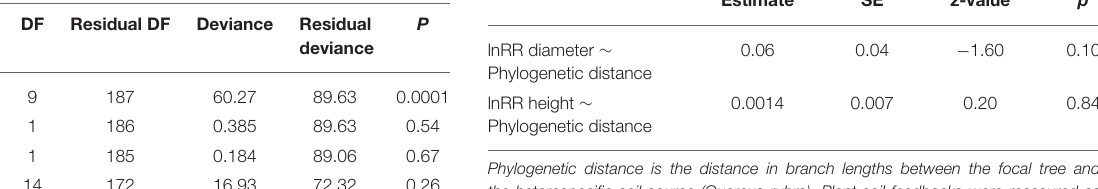
TABLE 1 | Results of the survival analyses for tree survival across 9 species in a tree restoration experiment with two soil treatments (conspecific soil, heterospecific soil from Quercus rubra ).